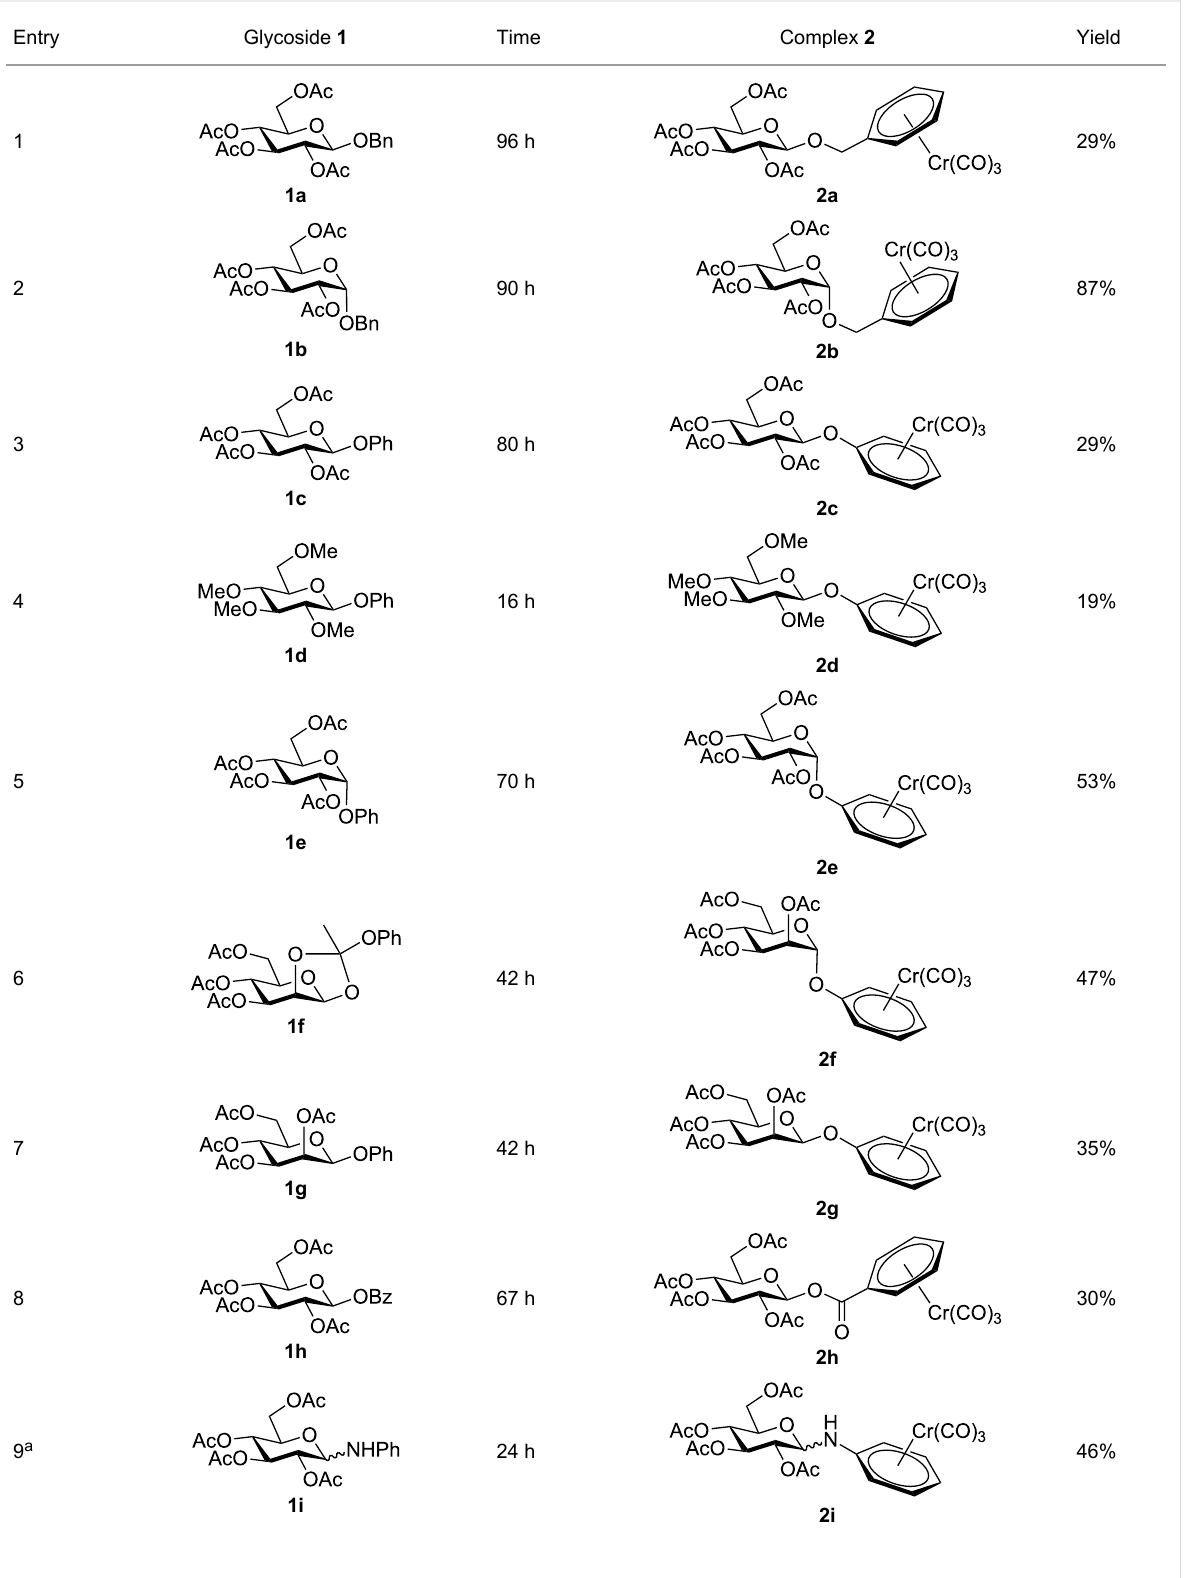
Table 1: Synthesis of η 6 -tricarbonylchromium complexes 2a – k from glycosides 1a – k and Cr(CO) 6 in di- n -butylether/THF 9:1 at 140 °C under Ar and exclusion of light.